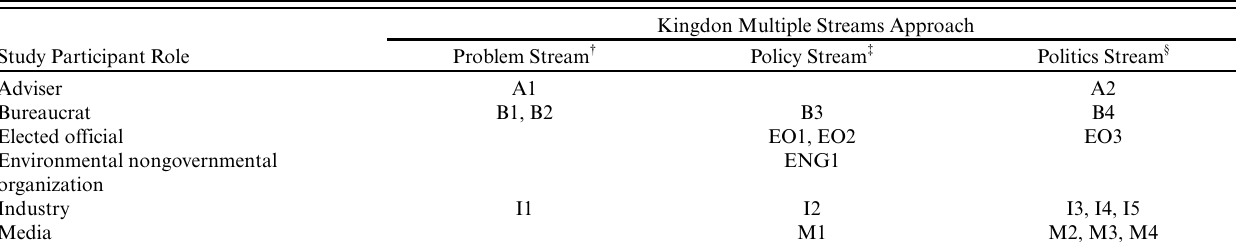
Table 3 . Study participant responses, Kingdon (2003) multiple streams